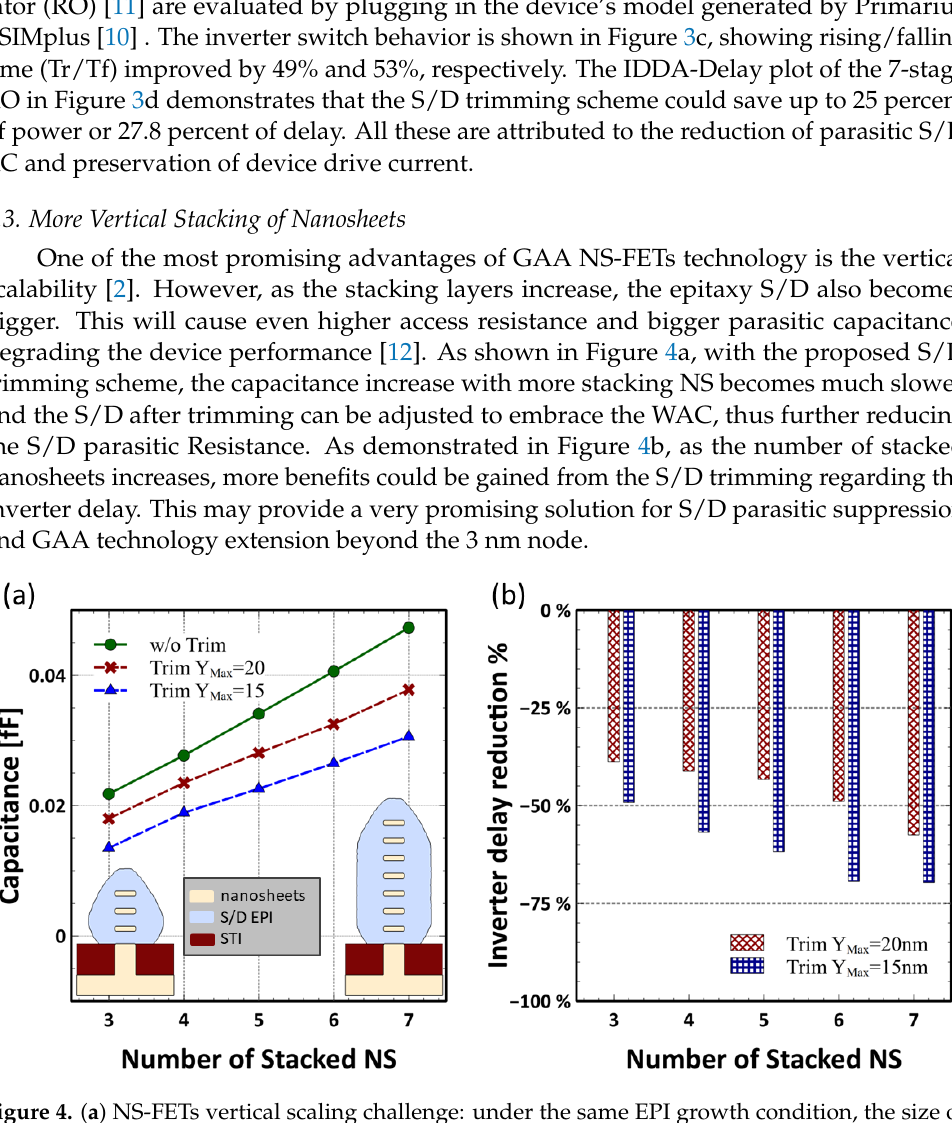
Figure 4. ( a ) NS-FETs vertical scaling challenge: under the same EPI growth condition, the size of S/D increases to accommodate more stacking layers, resulting in worse parasitic RC performance. ( b ) Inverter delay reduction percentage is calculated based on the corresponding un-trimmed case. Higher stacking NS benefits more by implementing the S/D trimming